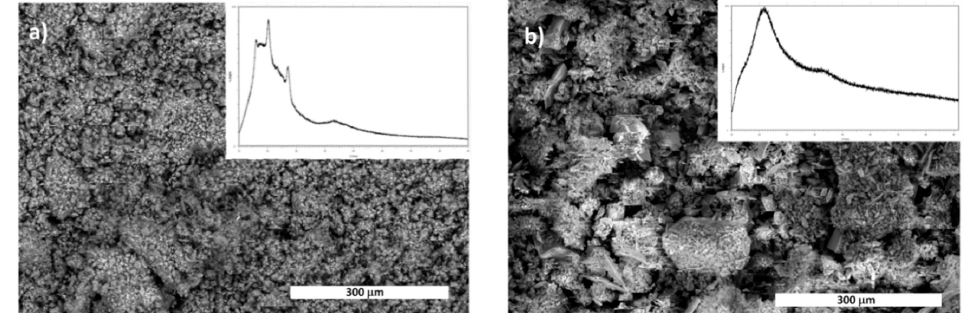
Figure 4. XRD diffractograms and SEM images of synthesized ( a ) PEF and ( b ) PHPF.